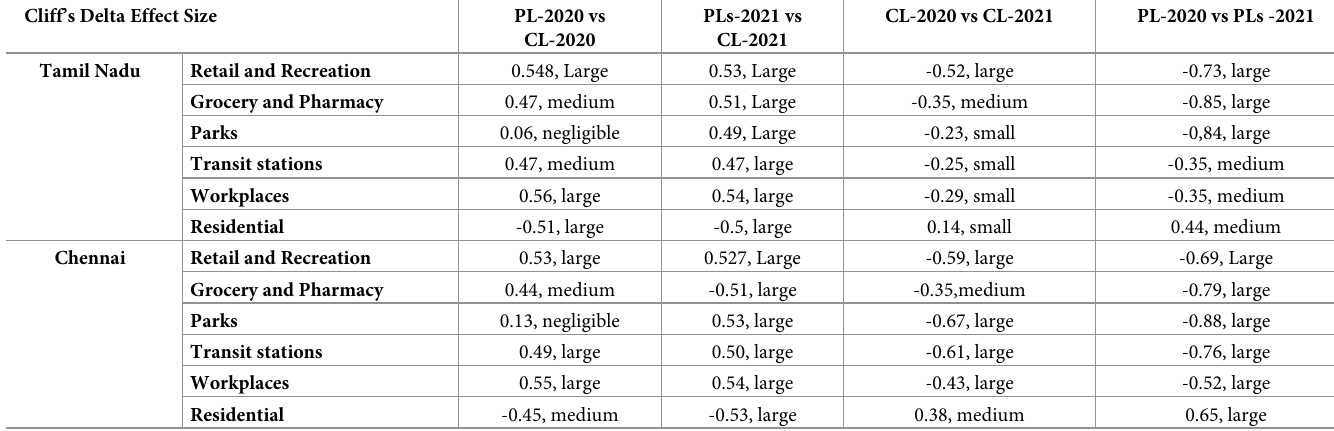
Table 5. Effect size for various group comparisons among various phases of lockdown during first and second waves of COVID-19 in the state of Tamil Nadu and city of Chennai. Cliff’s Delta Effect